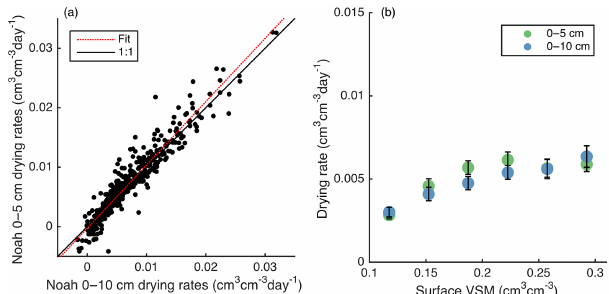
Figure 12. (a) Scatter plot comparing Noah drying rates between simulations with different surface layer depths. R = 0.93. Best fit intercept = 0, slope = 1.06. (b) Drying rate as a function of VSM for six quantiles using the two Noah simulation depths. Markers show median values. Error bars show standard